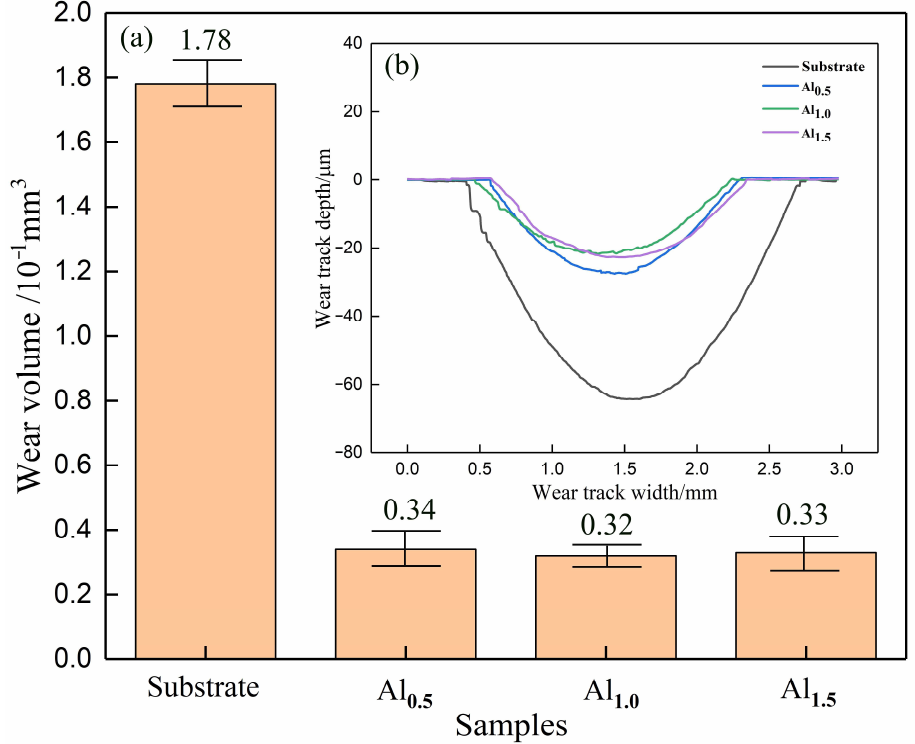
Figure 9. ( a ) Volume losses and ( b ) worn profiles tested by automatically moving the probe with a low speed of 0.3 mm/s and a high resolution of 0.02